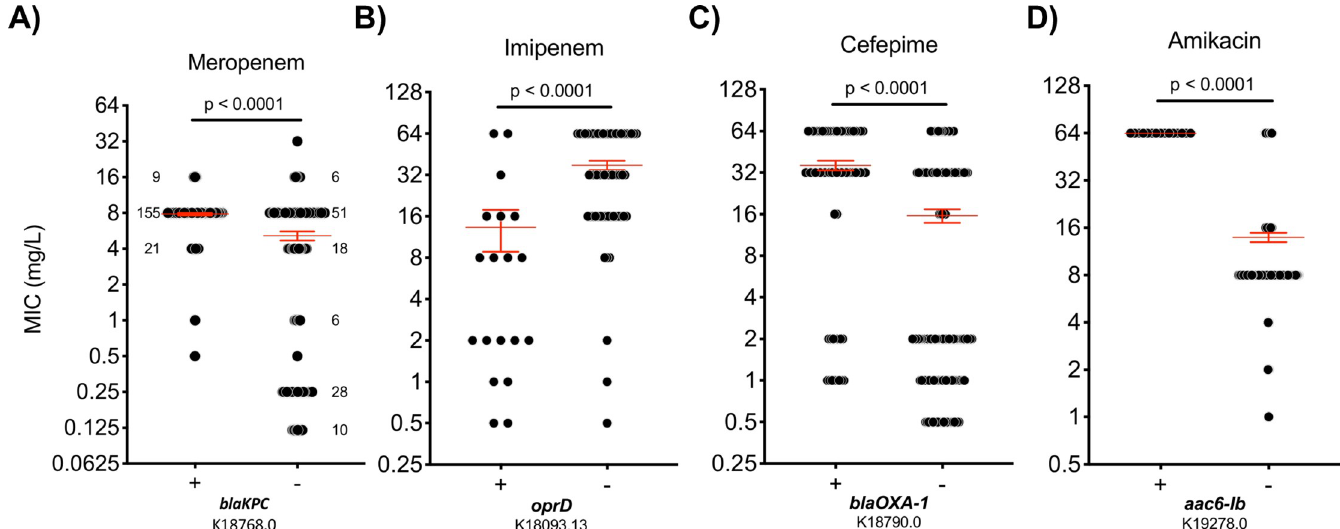
Fig 3. Examples of variant-phenotype relationships determined by the association models. (A) K18768.0 indicates blaKPC, the K . pneumoniae carbapenemase. The presence of blaKPC is associated with resistance to ceftazidime in K . pneumoniae as shown. The numbers in the plots represent the frequency of certain MIC (minimal inhibitory concentration) values. Numbers in the plot represent total number of isolates with the given MIC value. (B) K18093.13 is oprD, an imipenem/basic amino acid-specific outer membrane pore; absence of oprD is associated with resistance to imipenem in P . aeruginosa . (C) K18790.0 represents blaOXA-1, the beta-lactamase class D OXA-1. Its presence is associated with resistance to cefepime in E . coli . (D) K19278.0 is aac6-lb gene. The presence of this variant is associated with amikacin resistance in A . baumannii . The “+” and “-”sign in the X-axis represent whether the wild-type gene exists or not. The red horizontal lines mark the mean and standard error of the groupwise MIC measurements. Each gray dot represents an MIC value. P-values are calculated based on Fisher’s exact test. MIC: minimal inhibitory concentration.